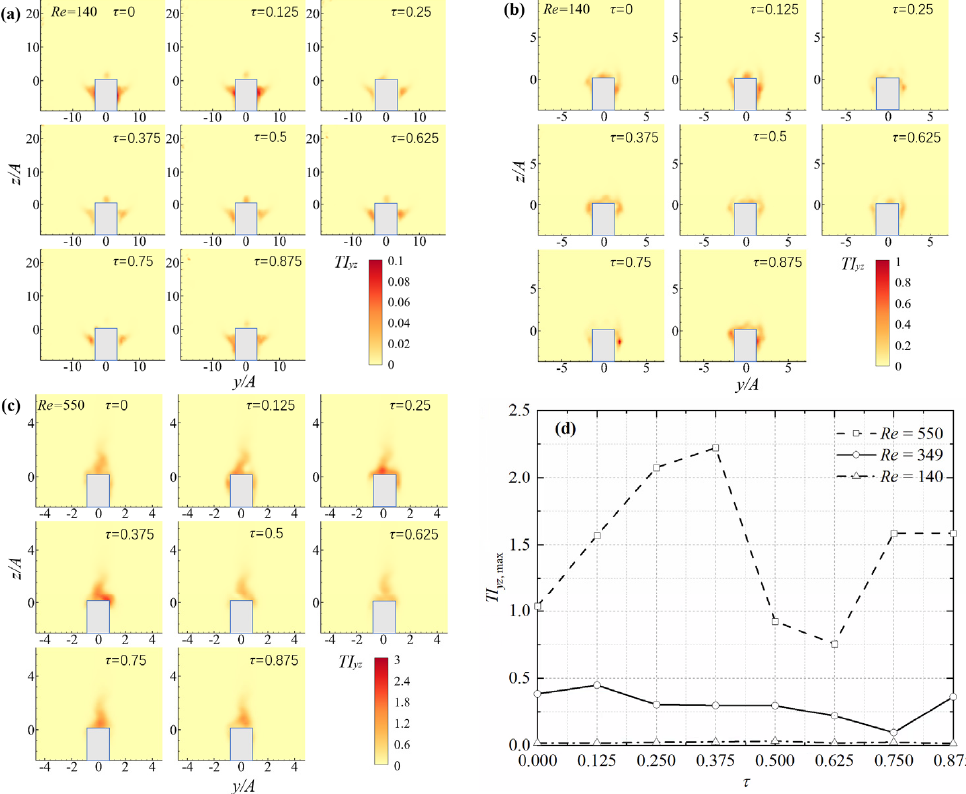
Figure 15. Turbulence intensity TI yz in the longitudinal plane for different Reynolds numbers ( Re = 140, 349, 550 for frame ( a – c ), respectively) and ( d ) maximum turbulence intensity TI yz , max during one cycle at three Reynolds numbers.